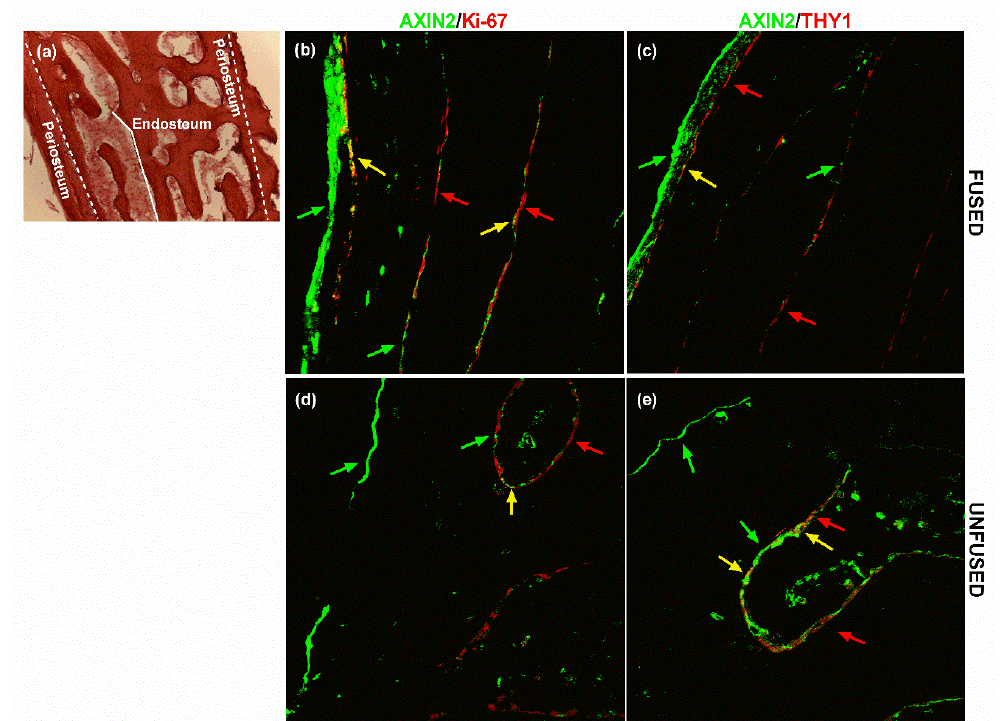
Figure 2. AXIN2 and THY1 expression in calvarial bone. ( a ) The haematoxylin/eosin staining displays the histological structure of a cross-section of the flat calvarial bone, showing the periosteum and endosteum location. Localisation of AXIN2/Ki-67 and AXIN2/THY1 expression in ( b , c ) fused and ( d , e ) unfused suture tissue sections, assessed by immunofluorescence. Green arrows highlight AXIN2+ cells, red arrows point out ( b , d ) Ki-67+ cells and ( c , e ) THY1+ cells. Yellow arrows indicate AXIN2+/THY1+ and AXIN2+/Ki-67+ cells. Pictures are representative of 90 microscopic fields from nine slides (technical replicates) at 20× magnification of three patients (biological replicates) (see Methods for details).